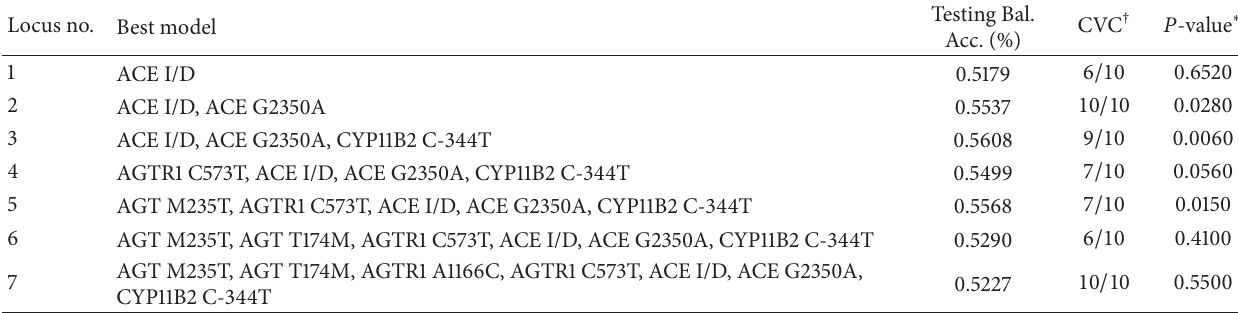
Table 4: Best gene-gene interaction models identified by the MDR method. Locus no. Best